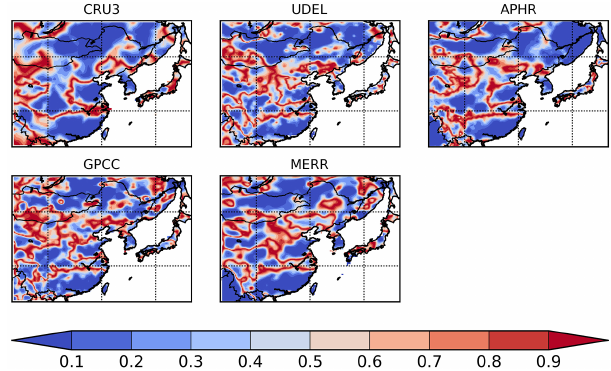
Figure 4. Same as in Fig. 3, but for the summer-mean precipitation